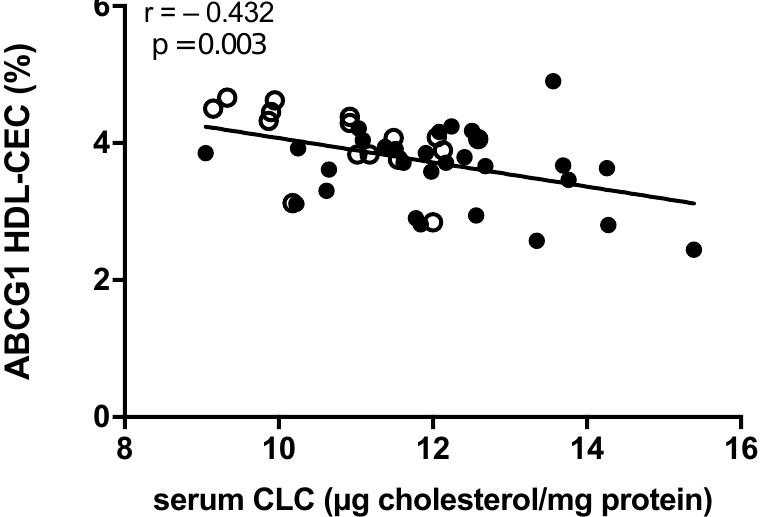
Figure 3. Correlation between ABCG1-mediated HDL-CEC and serum cholesterol loading capacity (CLC) in FH subjects. Pearson correlation coefficient was reported. : subjects not presenting ATX; : subjects presenting ATX.